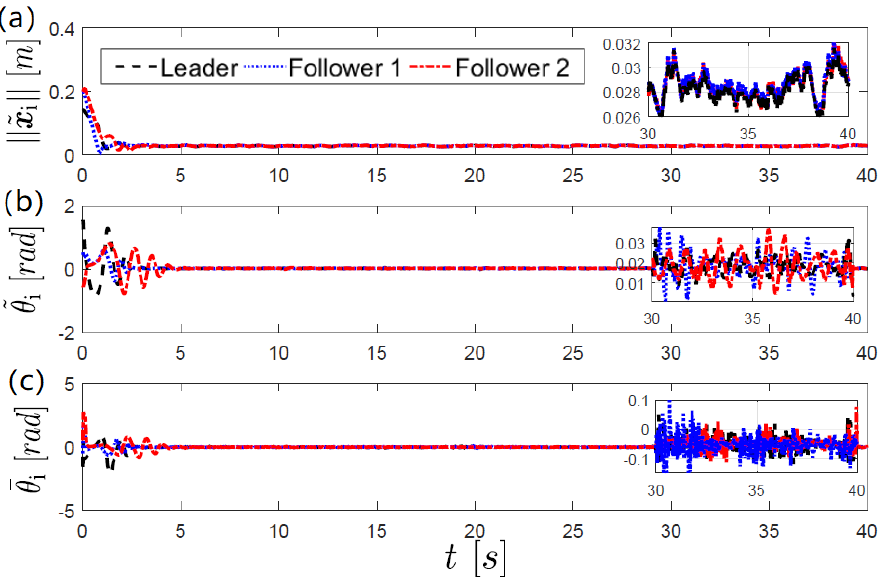
Figure 5. Time evolution of the position and attitude errors in the first experiment (circular path):